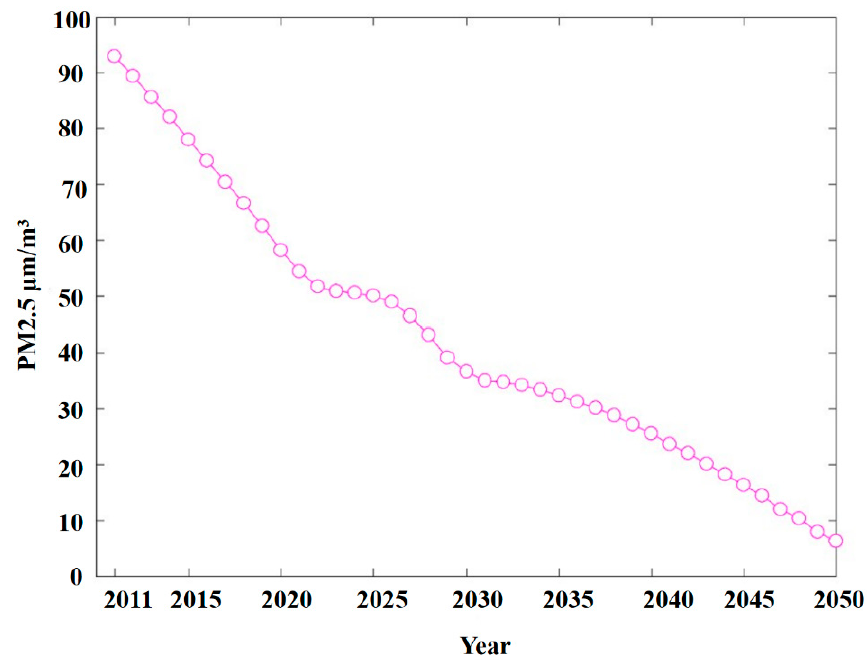
Figure 14. Impact of cross-regional collaborative governance policy on PM2.5 in Beijing.